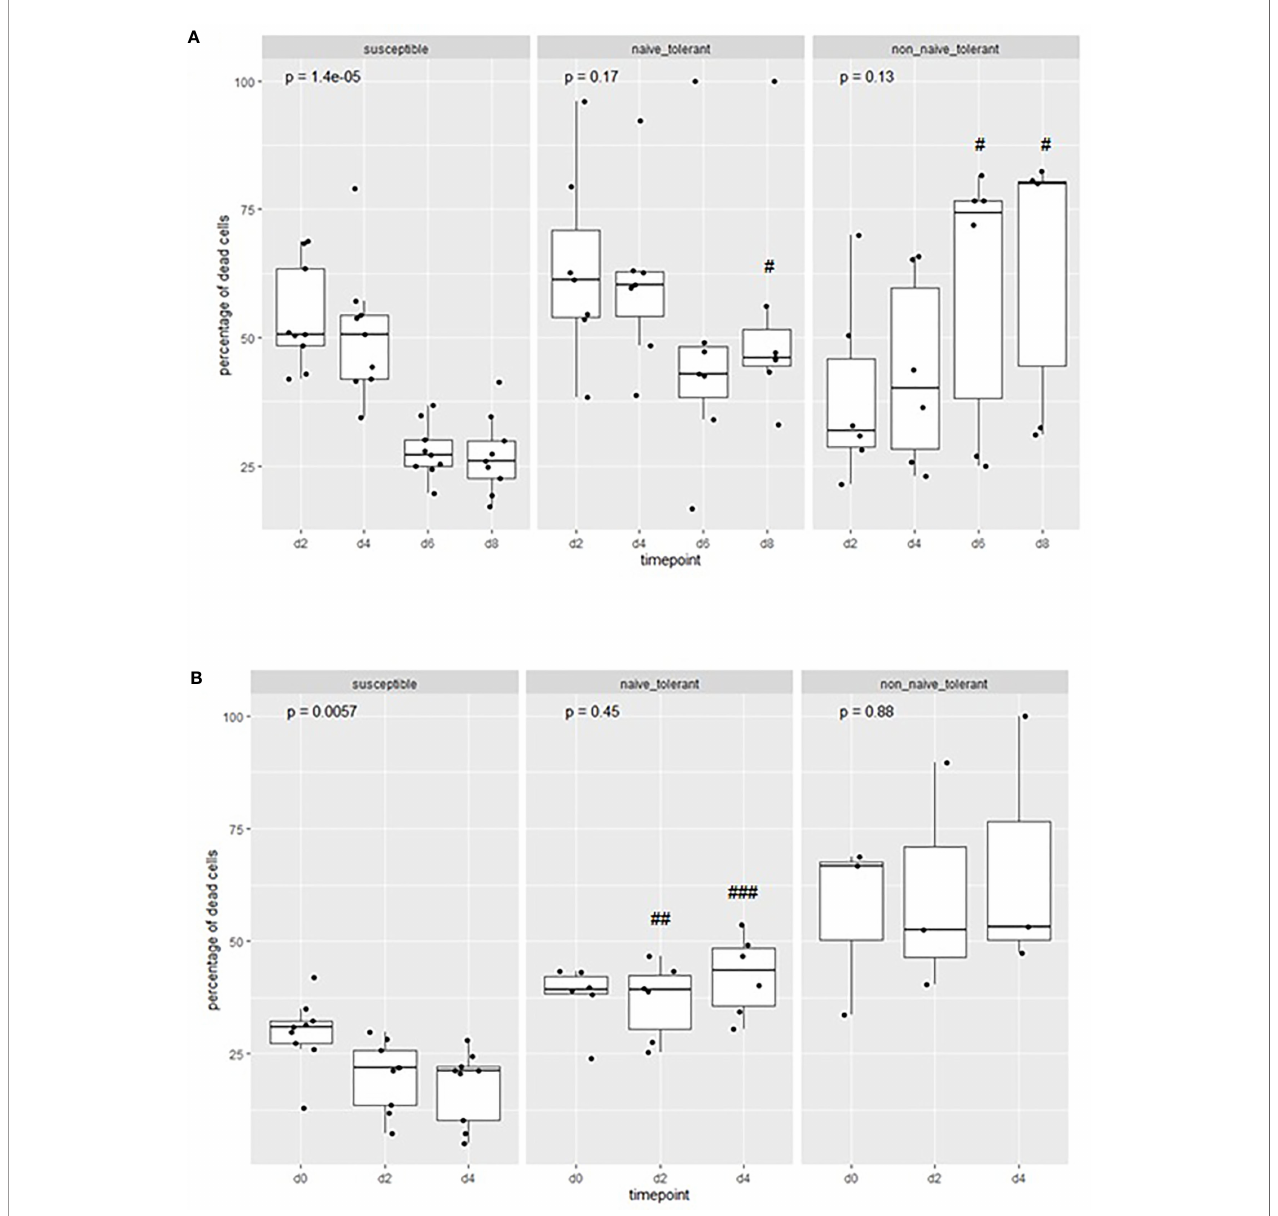
FIGURE 4 | Proportions of dead cells in cultures from tolerant and susceptible animals: The percentage of dead cells in cultures of cells derived from tolerant and susceptible cattle during the fi rst (A) and second (B) week of culture after infection in vitro . The p values represent the probability of a difference in the percentage of cells at different days within each group (Kruskal-Wallis test). The probability of a difference in percentage of dead cells at the same day between susceptible and tolerant populations is shown as # p < 0.05; ## p <0.01; ### p< 0.001 (Wilcoxon